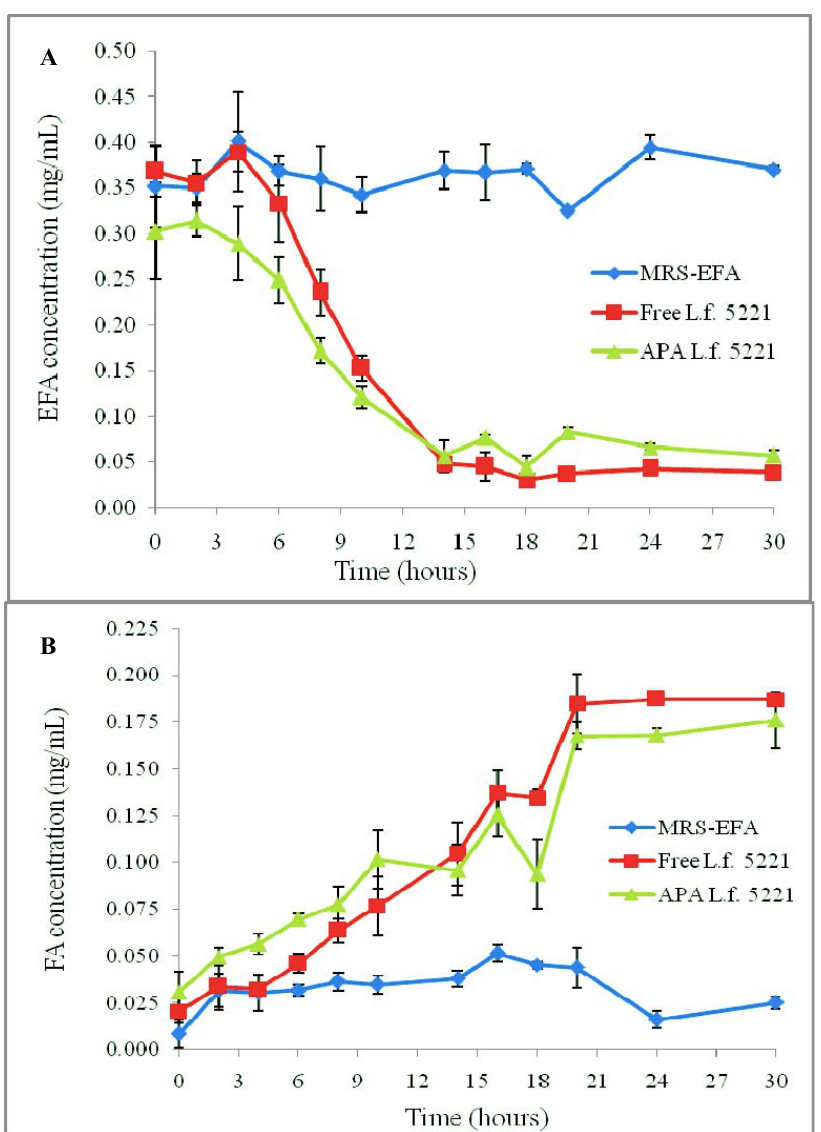
Figure 4 . FAE quantitative HPLC assay of free (free L.f. 5221) and microencapsulated L. fermentum NCIMB 5221 (APA L.f. 5221). Uninoculated MRS-EFA was used as